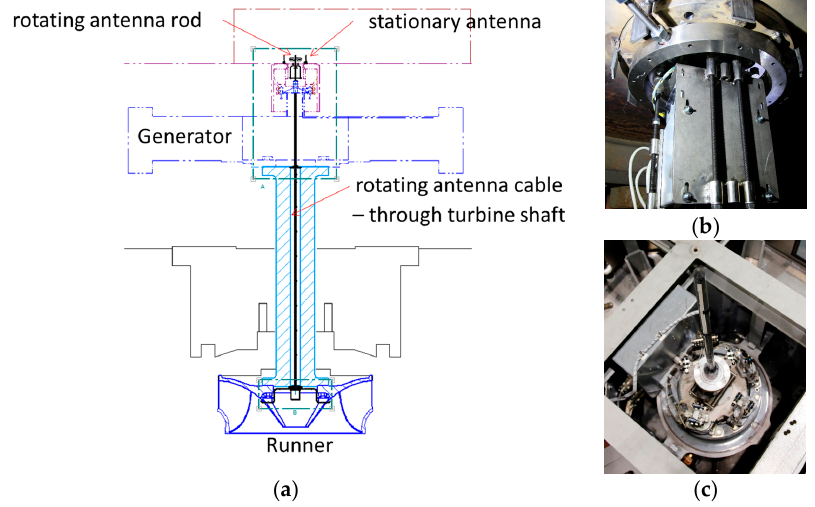
Figure 3. Detail of the telemetry system installed in the rotating train of the Francis turbine. ( a ) Sketch of the telemetry system; ( b ) picture of the telemetry system installed in the hub of the runner; ( c ) rotating antenna at the tip of the shaft.